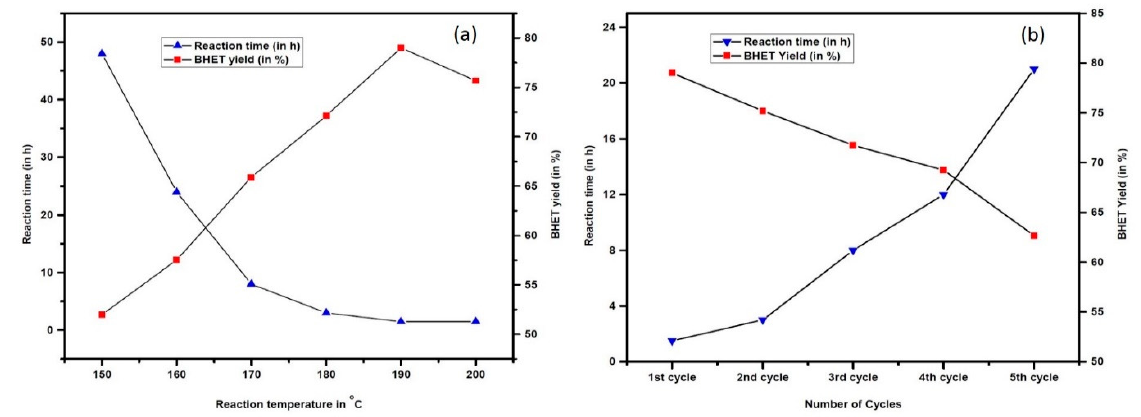
Figure 6. ( a ) Effect of reaction time on PET depolymerisation. The reaction was conducted using 2.5 mmol of PET, 16 equivalents of EG and 10 wt % of OPA, and ( b ) Reusability of OPA catalyst. The reaction was conducted using 2.5 mmol of PET, 16 equivalents of EG and 10 wt% of OPA